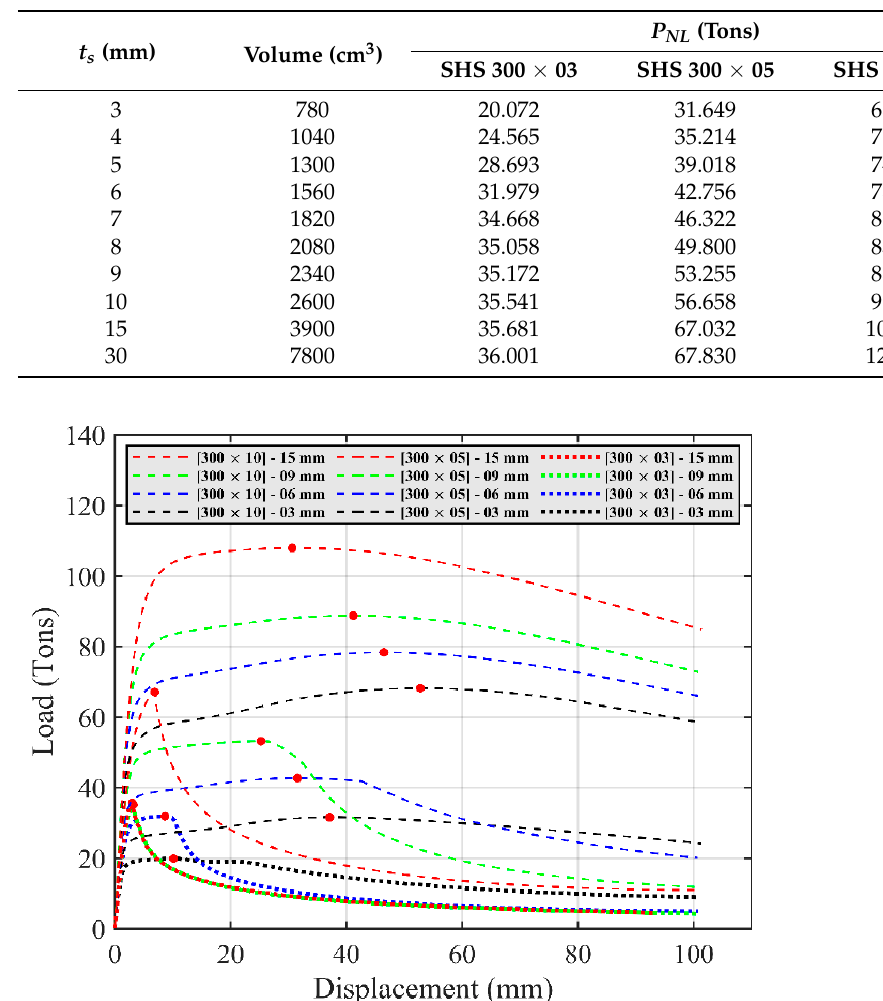
Figure 9. Load-displacement responses of SHS columns with uniform external stiffeners.